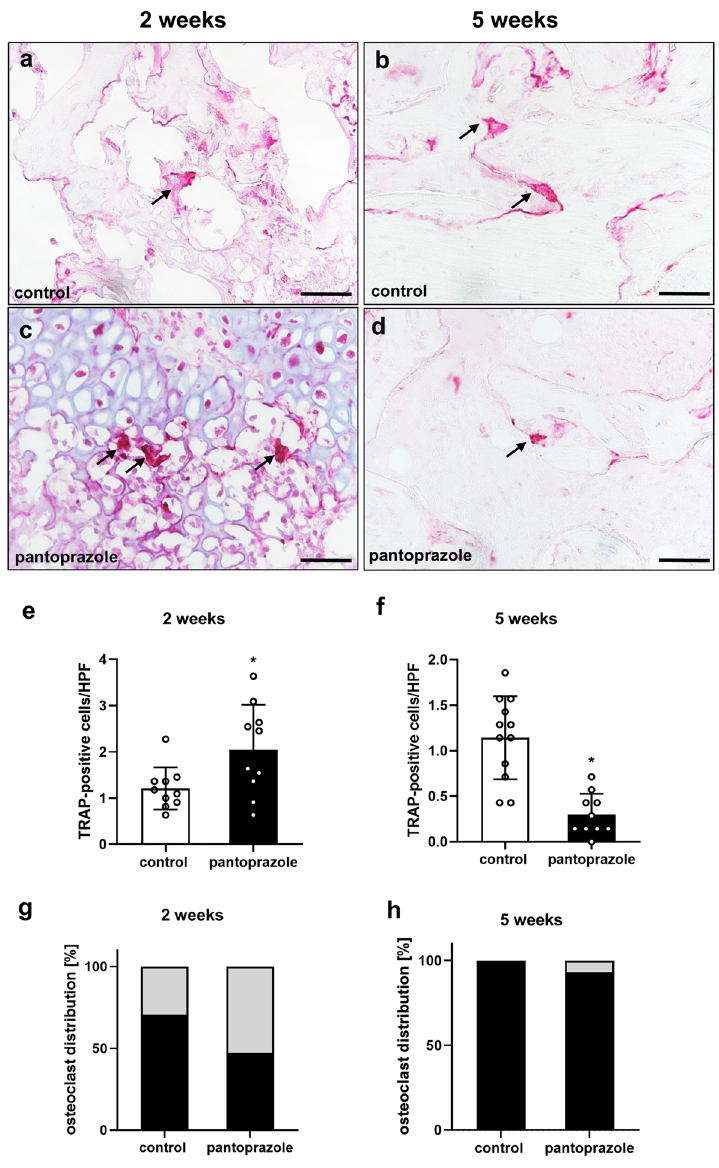
Figure 4. Histological analysis of osteoclastogenesis. ( a – d ) Representative histological sections of TRAP- positive osteoclasts (arrows) at 2 weeks ( a , c ) and 5 weeks ( b , d ) after fracture healing in controls and pantoprazole-treated animals. Scale bars: 50 µm. ( e , f ) Quantitative analysis of the number of TRAP-positive cells per high-power field ( HPF ) in the callus tissue at 2 weeks ( e ) and 5 weeks ( f ) of controls (white bars) and pantoprazole-treated animals (black bars). ( g , h ) Distribution of osteoclasts [%] within the osseous tissue (black) and cartilaginous tissue (gray) at 2 weeks ( g ) and 5 weeks ( h ) after fracture healing in controls and pantoprazole- treated animals. Means ± SD; n = 10–12; *p < 0.05 vs.